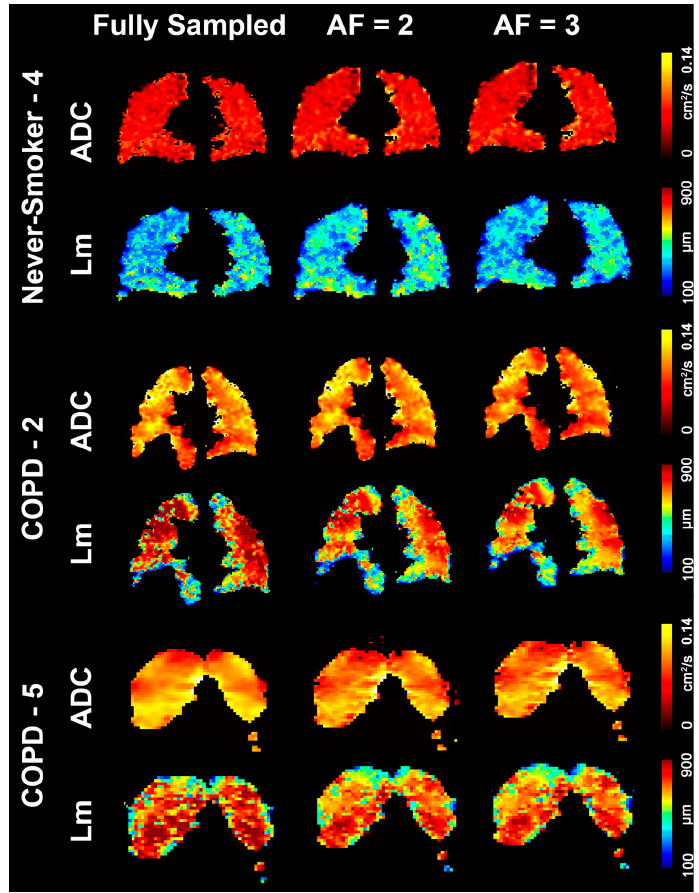
Figure 2. Representative 129 Xe ADC and L m map for elderly never-smoker, COPD participant and AATD participant. Never-smoker-4 is a 71-year-old female with FEV 1 = 105% pred , DL CO = 94% pred , RA 950 = 0.1%, and VDP= 4%. COPD-2 is a 69-year-old male COPD ex-smoker with FEV 1 = 59% pred , DL CO = 43 , RA 950 = 12%, and VDP = 15%. COPD-5 is a 66-year-old male AATD never-smoker with apparent-diffusion-coefficient.